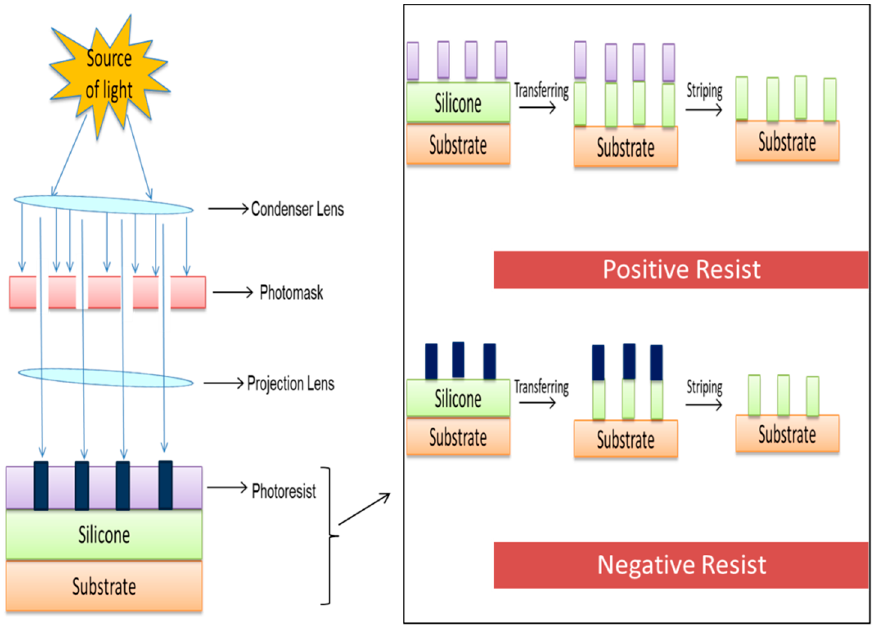
Figure 15. Schematic illustration of surface engineering method demonstrating the basic working principle of lithography on a substrate. Lithography has two results after the rays of source come into contact with a photoresist surface: positive resists and negative